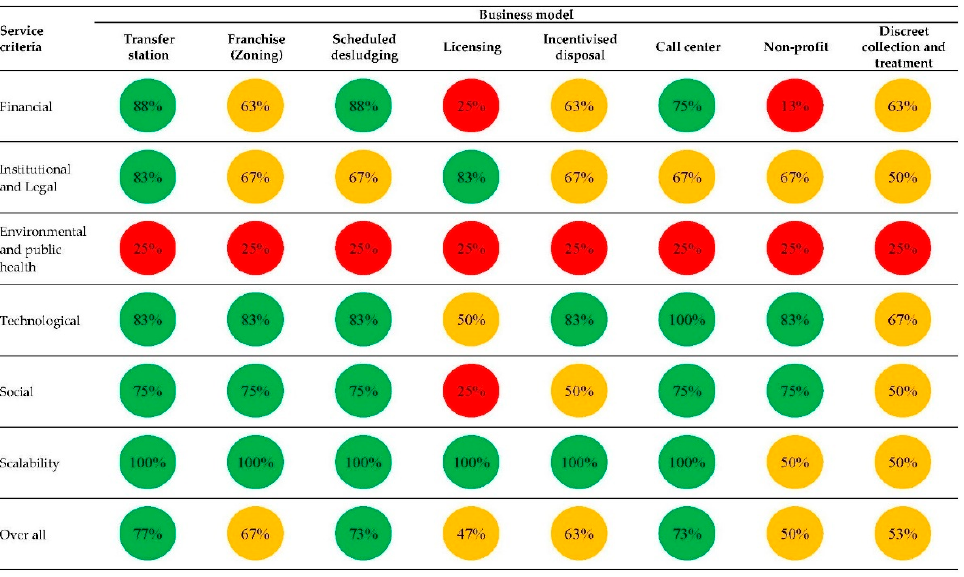
Figure 2. Business model scorecard for cesspool (Supplementary material S2).